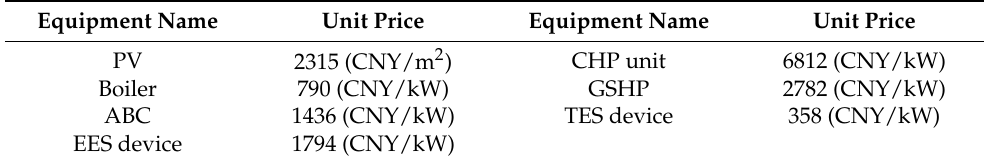
Table 4. The initial unit investment in equipment Reproduced from